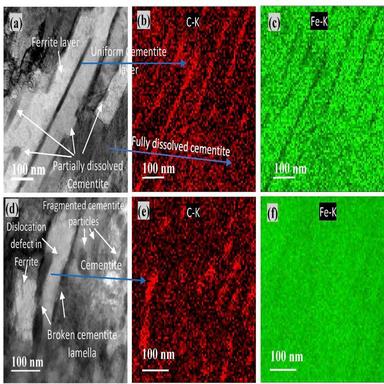
Microstructural characterisations of the two different WELs samples obtained from interface location, showing the configuration and decomposition behaviour of cementite lamella. (a) The BF STEM images (electron image) of sample A (heavy braking regions), (b) and (c) its corresponding (C-K) and iron (Fe-K) EDS mapping. (d) BF STEM images (electron image) of sample B (steady traffic regions), (e) and (f) its corresponding (C-K) and iron (Fe-K) EDS mapping.